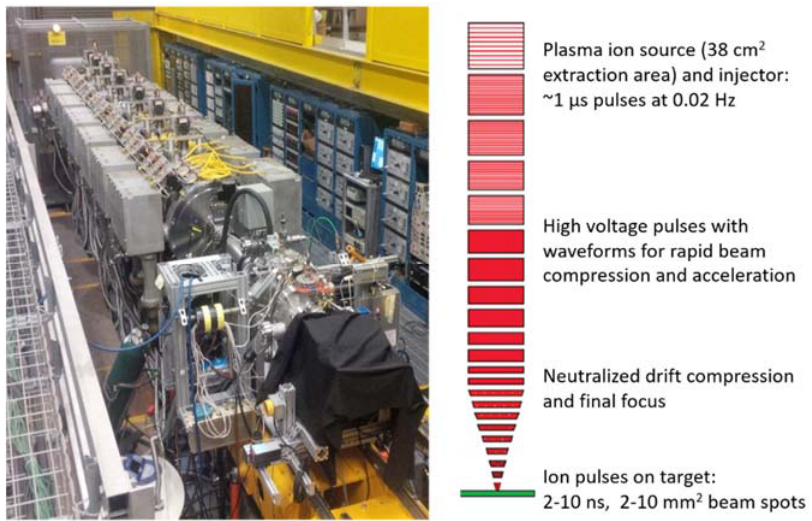
Figure 1. Photo of NDCX-II, an ion induction LINAC at Berkeley Lab [6,19], and an illustration of its operating principles for the formation of ns ion pulses by neutralized drift compression.